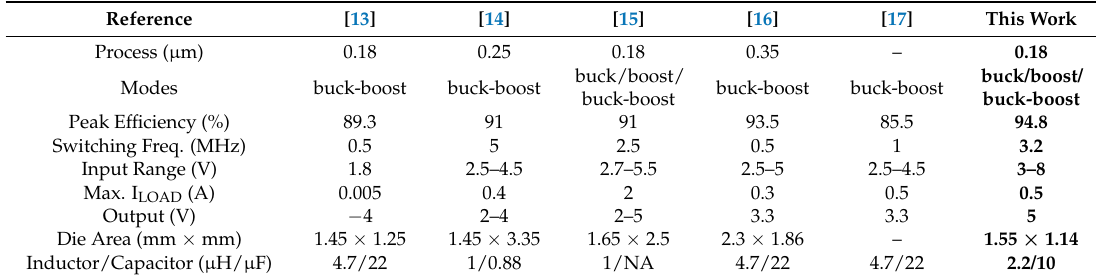
Table 1. Performance comparison with prior works.